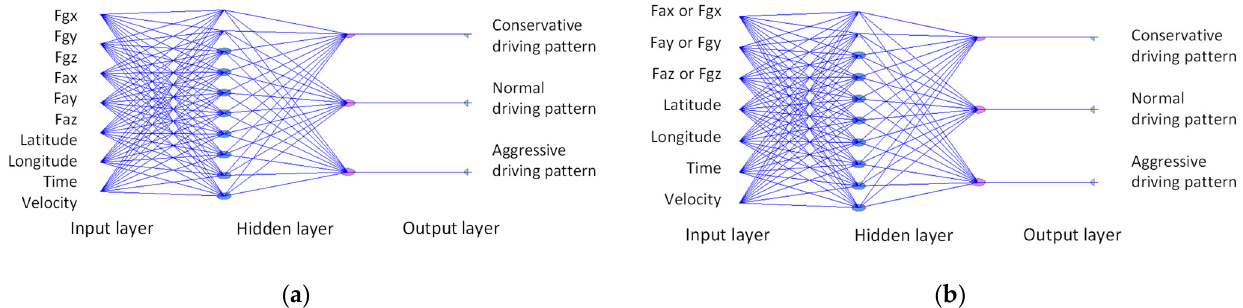
Figure 6. ANN design for the automatic recognition of driving parameters ( a ) using ten parameters and ( b ) using seven parameters.